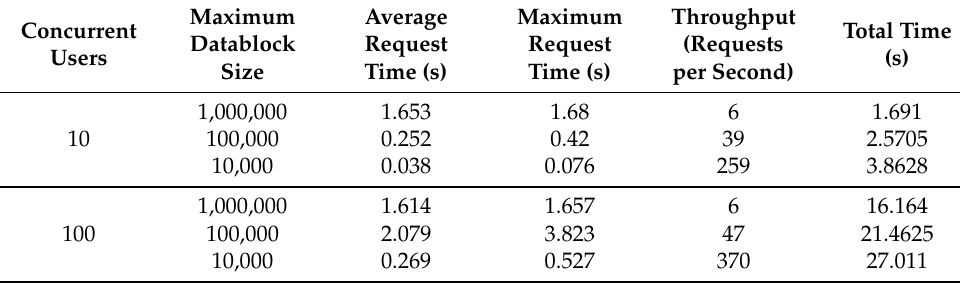
Table 6. Results of the concurrent requests test in MongoDB.